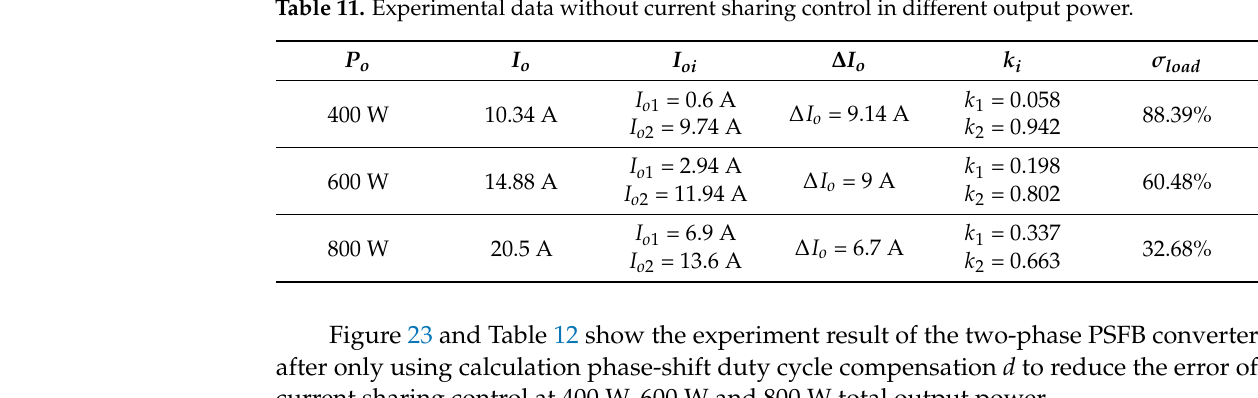
Figure 22. Experimental result of output current without current sharing control in different P o :